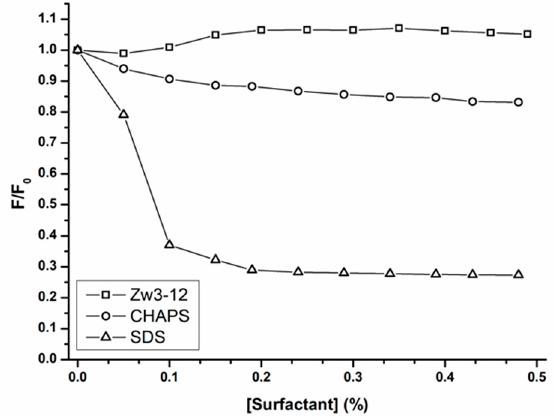
Figure 4. The emission intensity of 10 µ M OVA at pH 7.4 (10 mM sodium phosphate buffer) in the presence of increasing concentrations of Zw3-12, CHAPS, or SDS. The λ max is situated around 337 nm, and remained unaffected by the presence of surfactants.